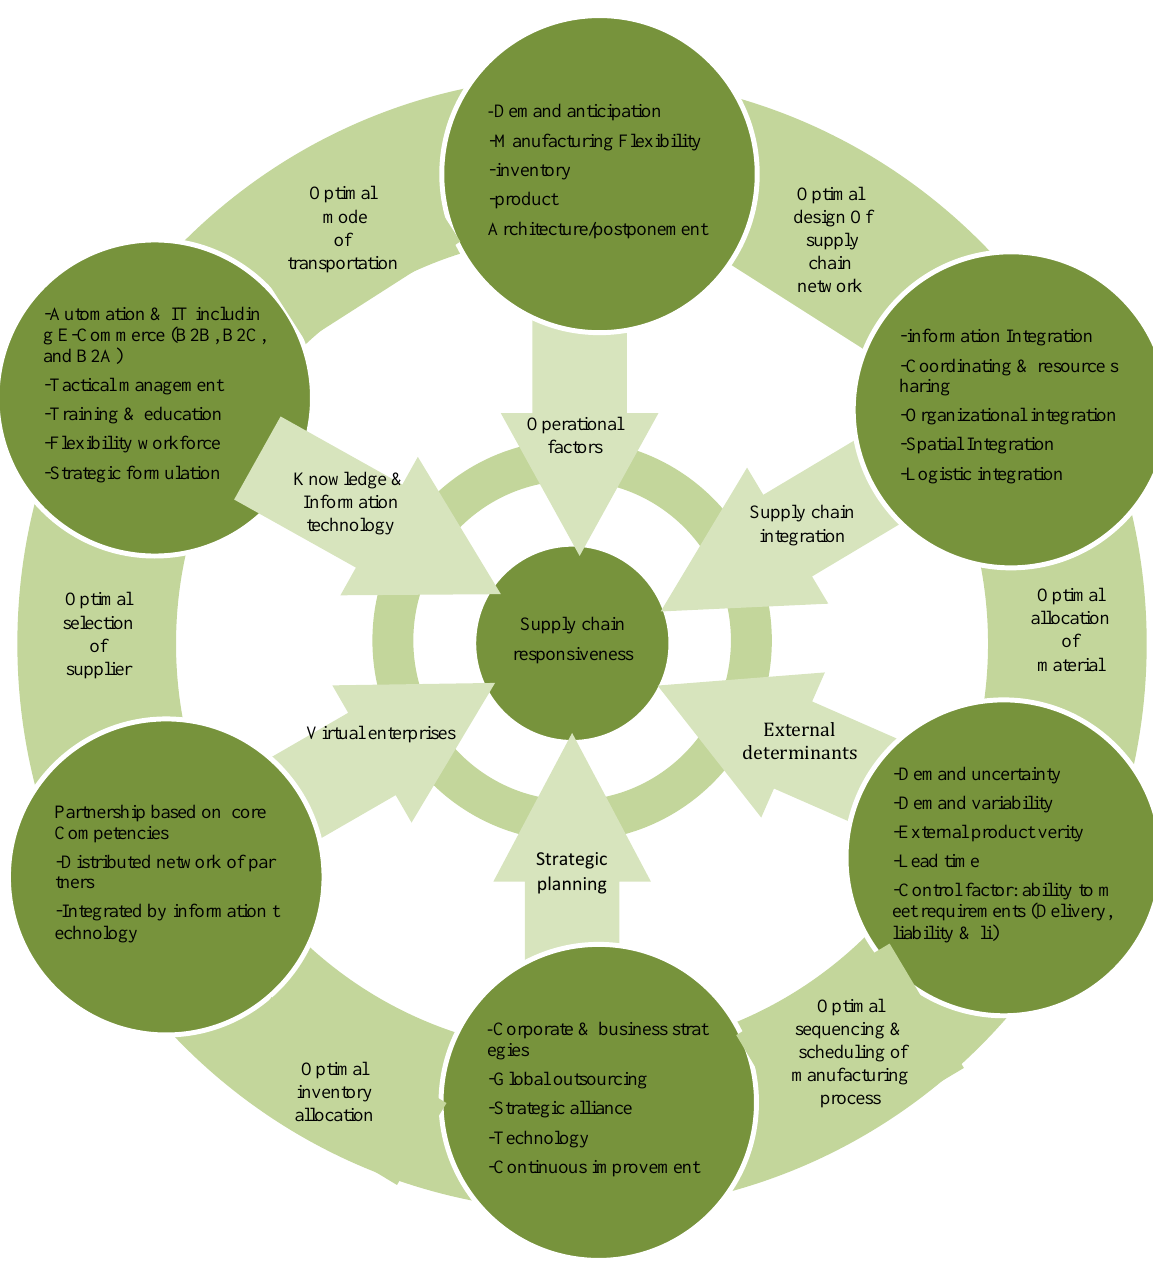
Fig. 6. Framework of responsive supply chain (figure modified from (Gunasekaran et al., 2008; Tiwari et al.,